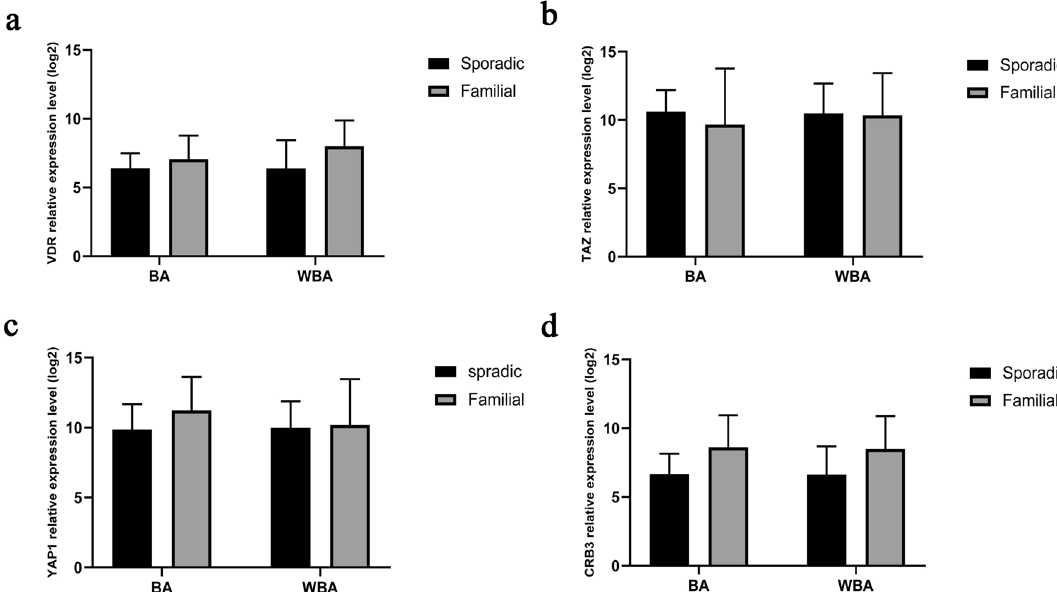
Figure 4. Comparison of gene expression of ( a ) VDR , ( b ) TAZ , ( c ) YAP1 , and ( d) CRB3 , in the Familial and Sporadic patients with and without brain atrophy. The columns represent the mean ± SD. Data were analyzed by two ‐ way ANOVA followed by LSD post hoc test. BA brain atrophy, WBA without brain levels, they still had higher levels of gene expression than controls. This can be related to the supplement dosage and treatment duration of the patients. Increased levels of the VDR gene may also be due to SNPs or miRNAs which may influence its expression. A synergistic effect between vitamin D and IFN-Beta is reported and the combination of vitamin D plus IFN-β reduced inflammatory cytokines and has potential benefit in ameliorating MS 39,40 . Thus, it is hypothesized that treatment with IFN-Beta, like vitamin D supplementation therapy, reduces the expression of the VDR over time. It seems that up-regulation of VDR in MS patients might have been even more prominent if we had excluded the effect of IFN-Beta on VDR expression. Sadeghi et al. have also investigated the expression level of VDR in RR-MS patients in comparison with normal individuals in the Iranian population. Similarly, the patients demonstrated a significantly higher expression level of VDR than the control group (p = 0.04) 41 . VDR expression has also been studied in other neurological diseases. Mazdeh et al. evaluated the expression of VDR in epileptic patients. They found significant downregulation of VDR expression in patients and suggested that it has a pathogenic role in epilepsy through attenuation of the physiologic functions of vitamin D in neuroprotection or regulation of the immune system 42 . Besides, Balta et al.